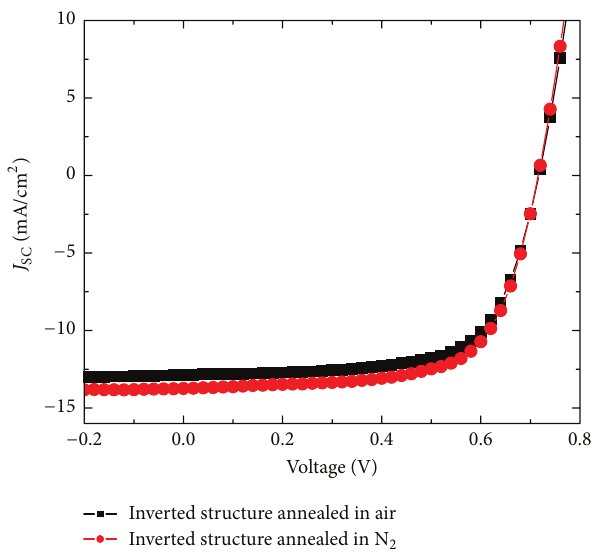
Figure 4: J - V characteristics for inverted OSCs with the ZnO buffer layer annealed in N 2 or air under the simulated AM 1.5G illumination of 100mW/cm 2